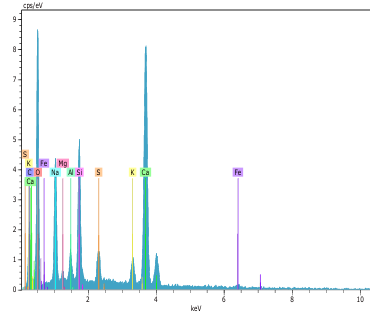
Figure 6. The chemical elements of EDS-tested healing products.